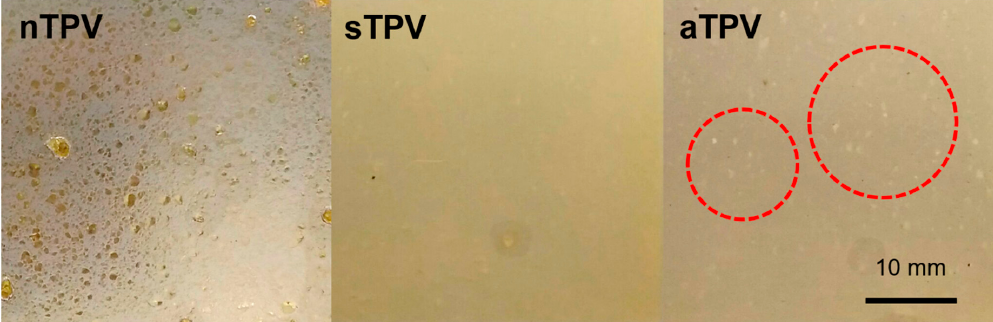
Figure 1. Optical appearance of compression molded TPV samples.